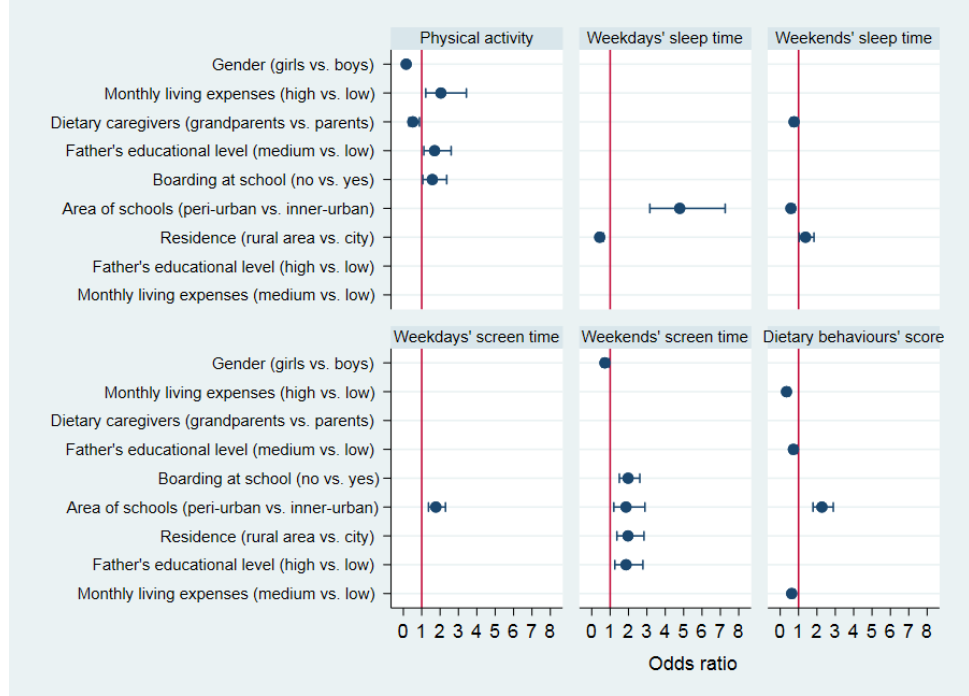
Figure 1. Stepwise logistic regression analysis for identifying factors affecting the lifestyle behaviours of high school students ( n =